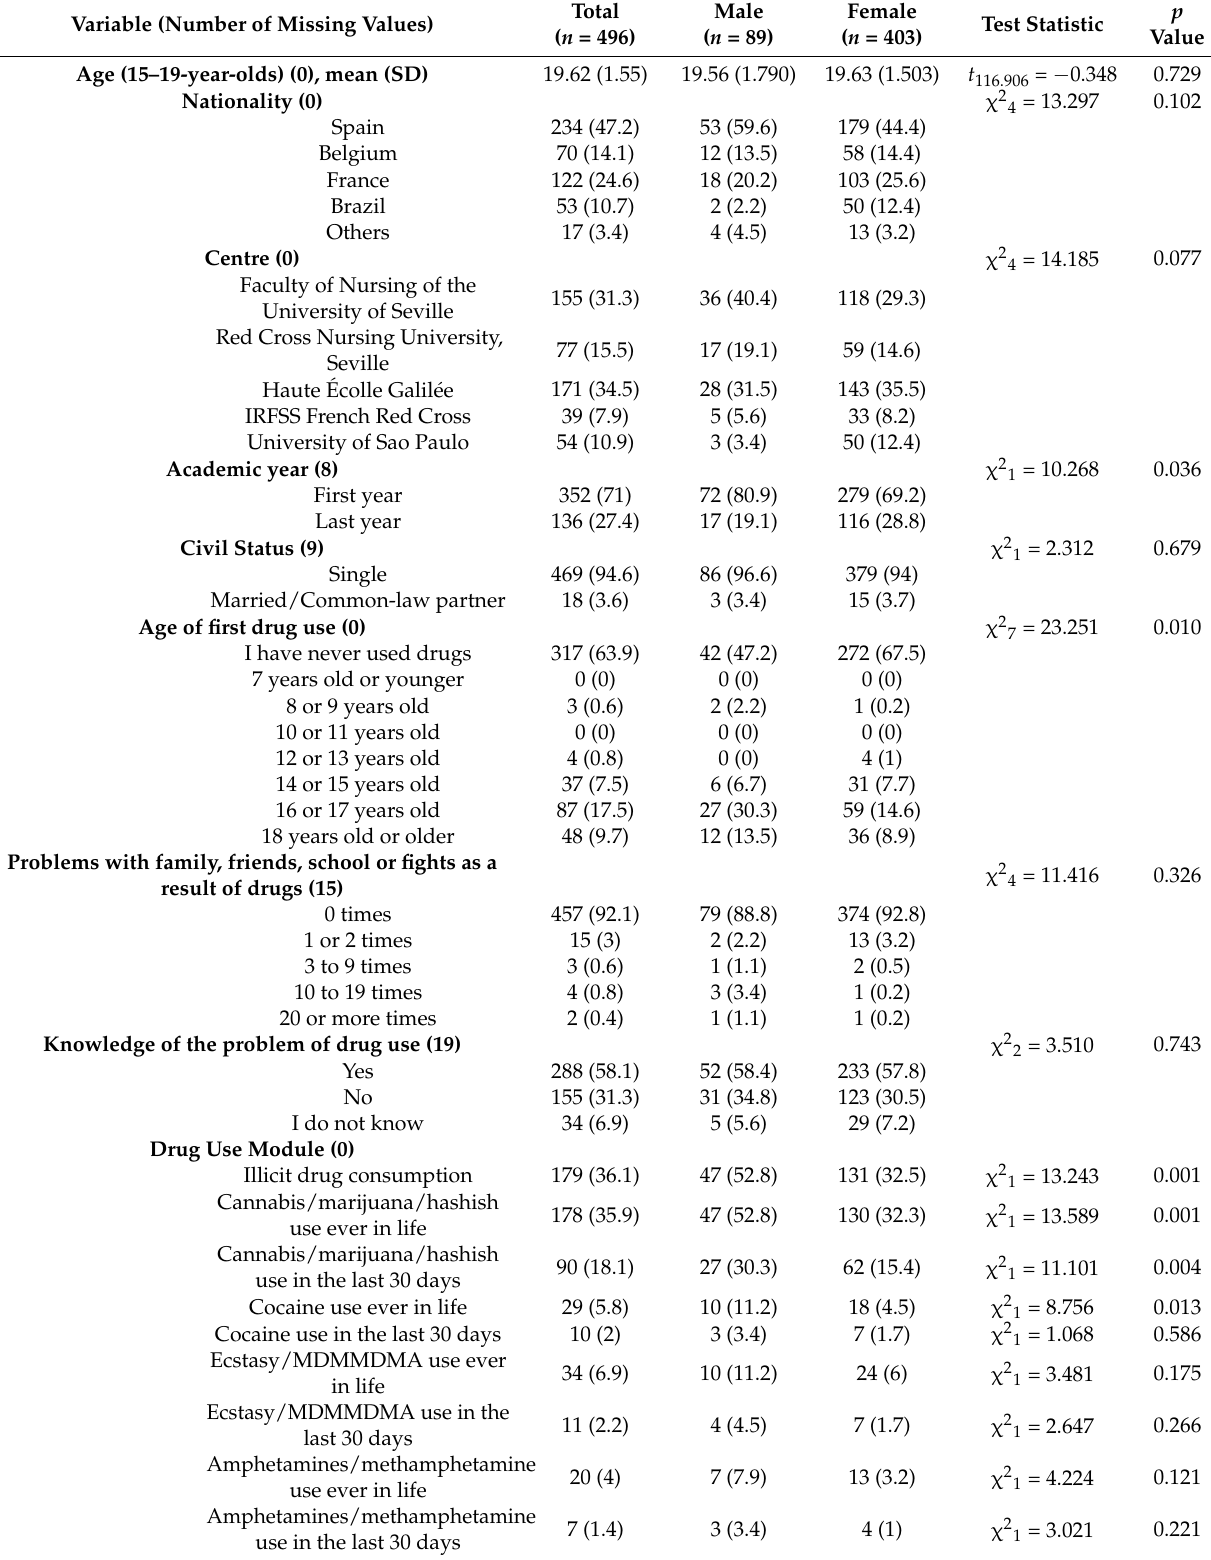
Table 1. Characteristics of participants. Differences by